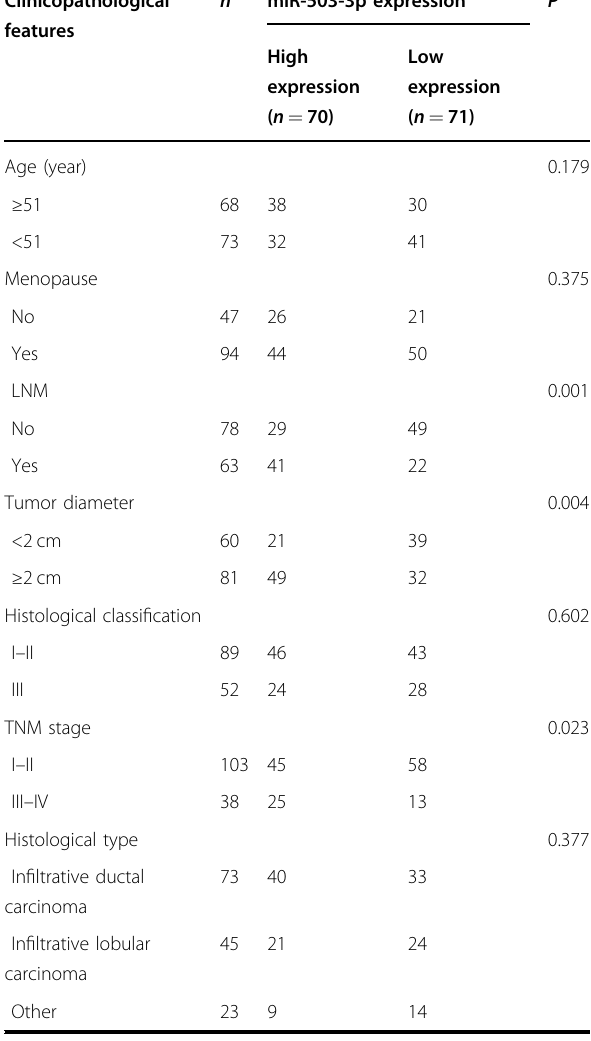
Table 2 Relation between miR-503-3p expression and clinicopathological characteristics of BC